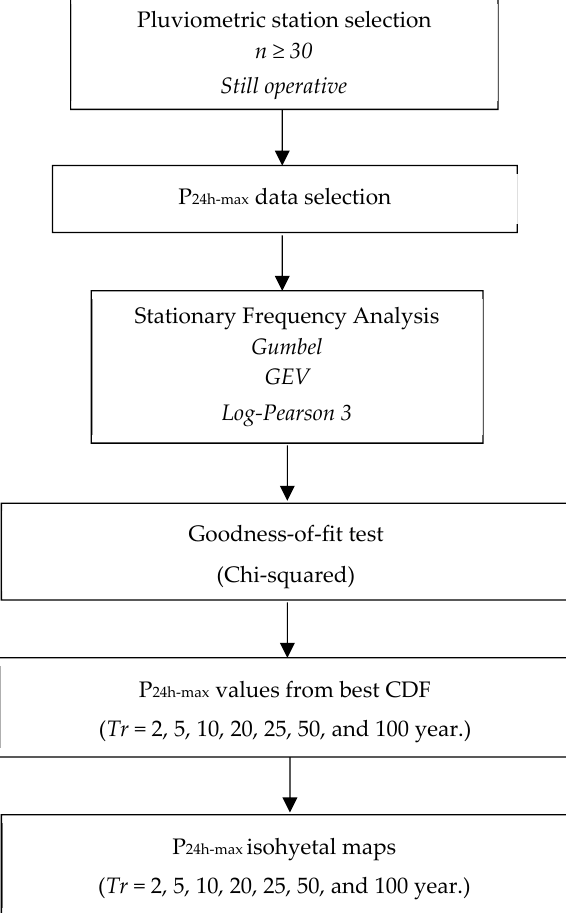
Figure 2. Flowchart of the proposed methodology.